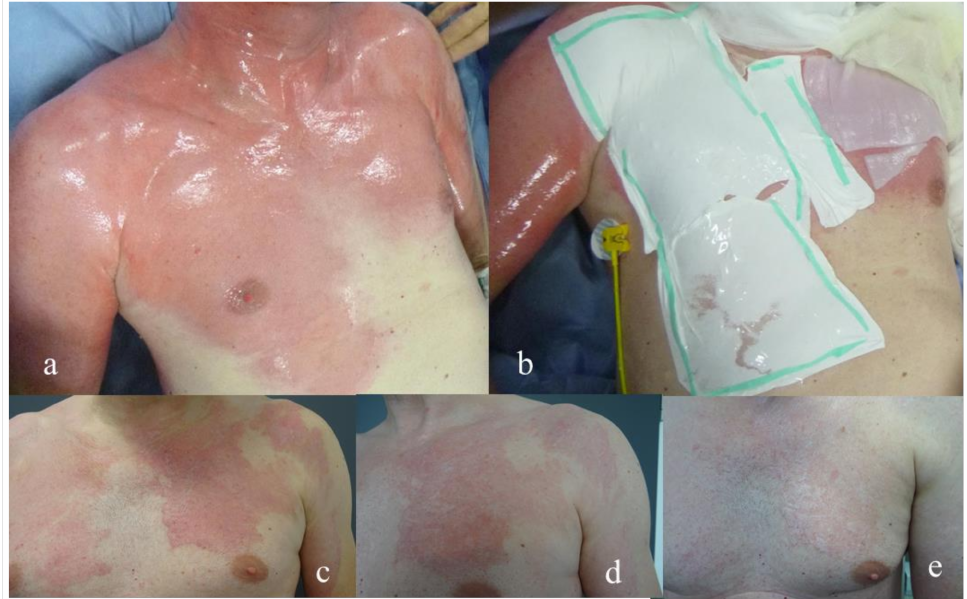
Figure 2. Patient with ( a ) superficial burn of the upper trunk. ( b ) treatment with epicite hydro® and Suprathel ® ( c ) results after 3 months ( d ) results after 6 months ( e ) results after 12